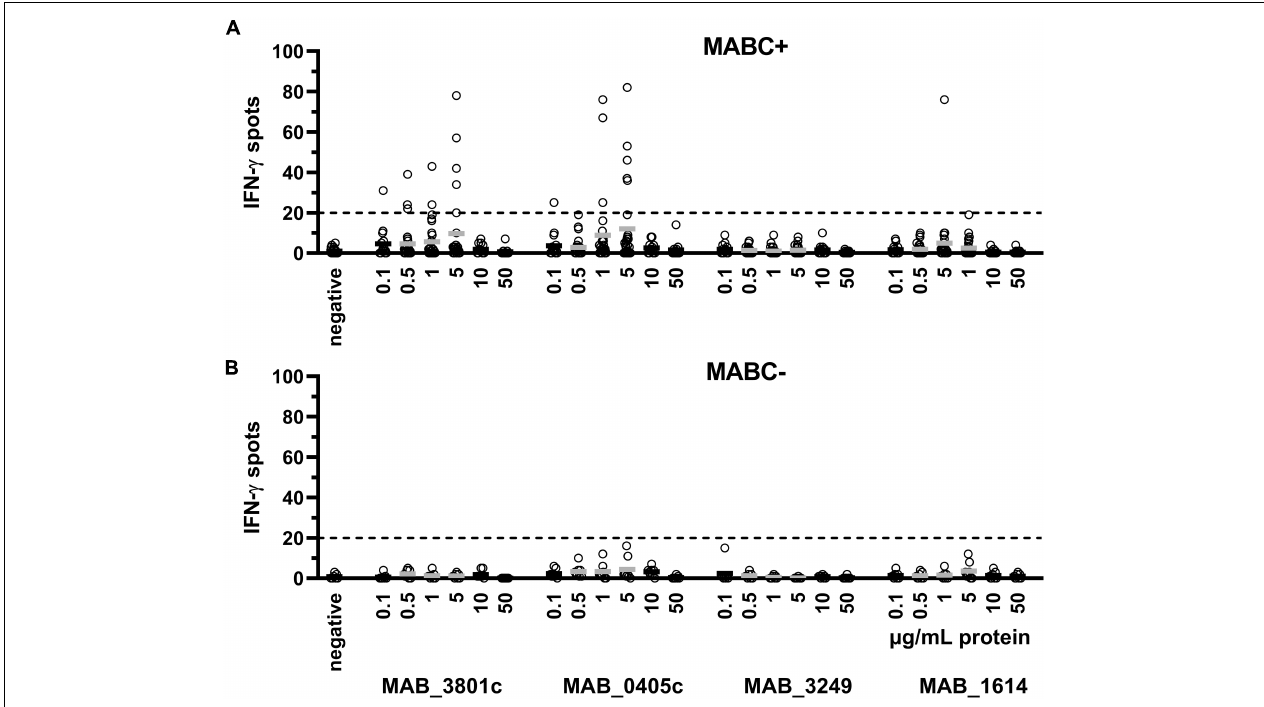
FIGURE 1 | PBMC were grown with six different concentrations of each of the four M. abscessus proteins MAB_3801c, MAB_0405c, MAB_3249, and MAB_1614 (0.1–50 µ g/ml), and IFN- γ production was determined by ELISpot. We analyzed cellular responses in patients with previous culture-confirmed M.